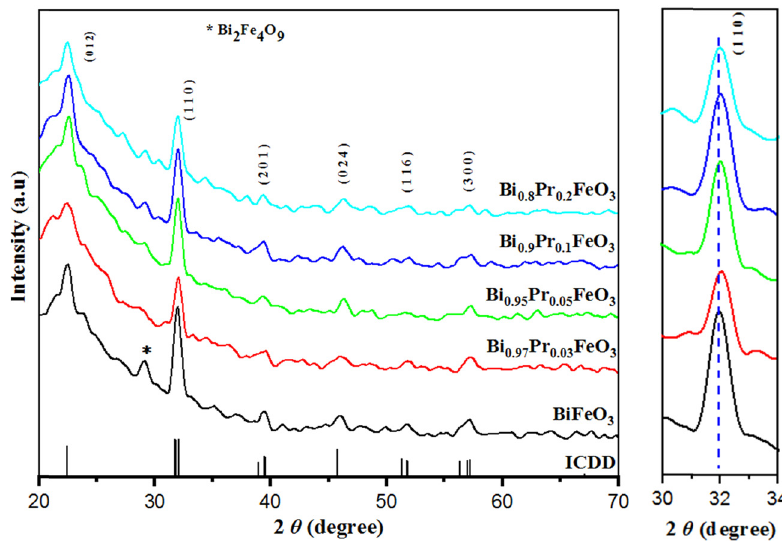
Figure 1: ( a ) Di ff raction patterns and ( b ) magni fi cation of the main peaks of Bi 1 − x Pr x FeO 3 fi lms.